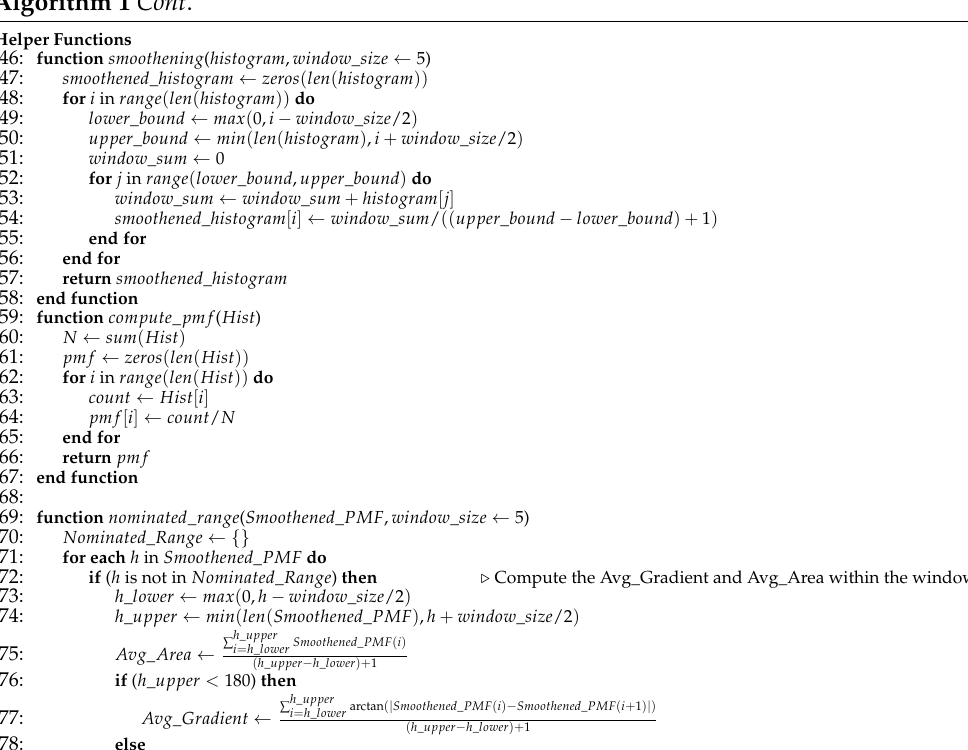
Algorithm 1 Cont